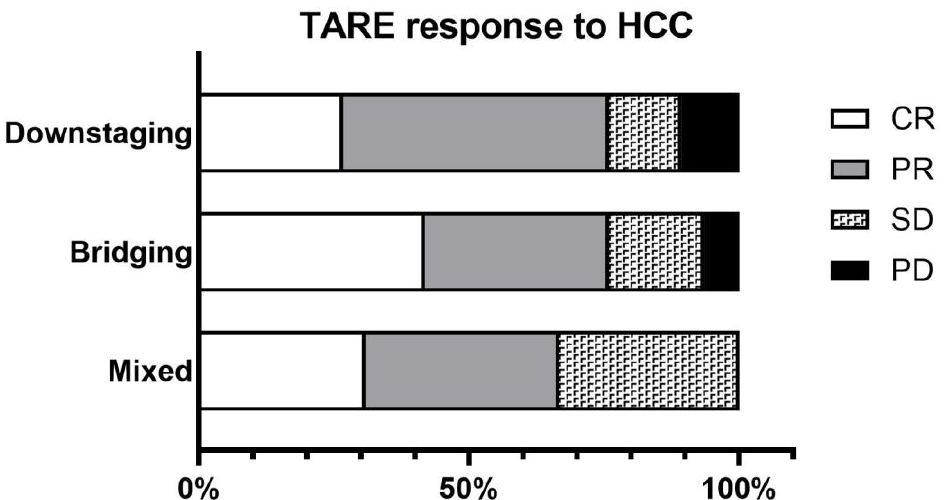
Figure 4. TARE response to HCC in 14 studies. Data on the effect of tumor treatment on TARE were extracted from each study and summarized: HCC: hepatocellular carcinoma, TARE: transarterial radioembolization, CR: complete response, PR: partial response, SD: stable disease, PD: progres- sive disease.